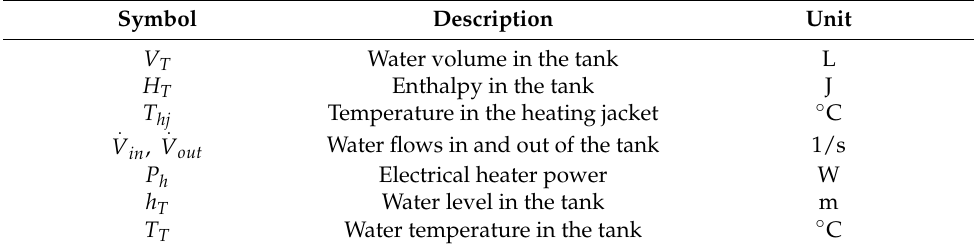
Table 1. The process variables and